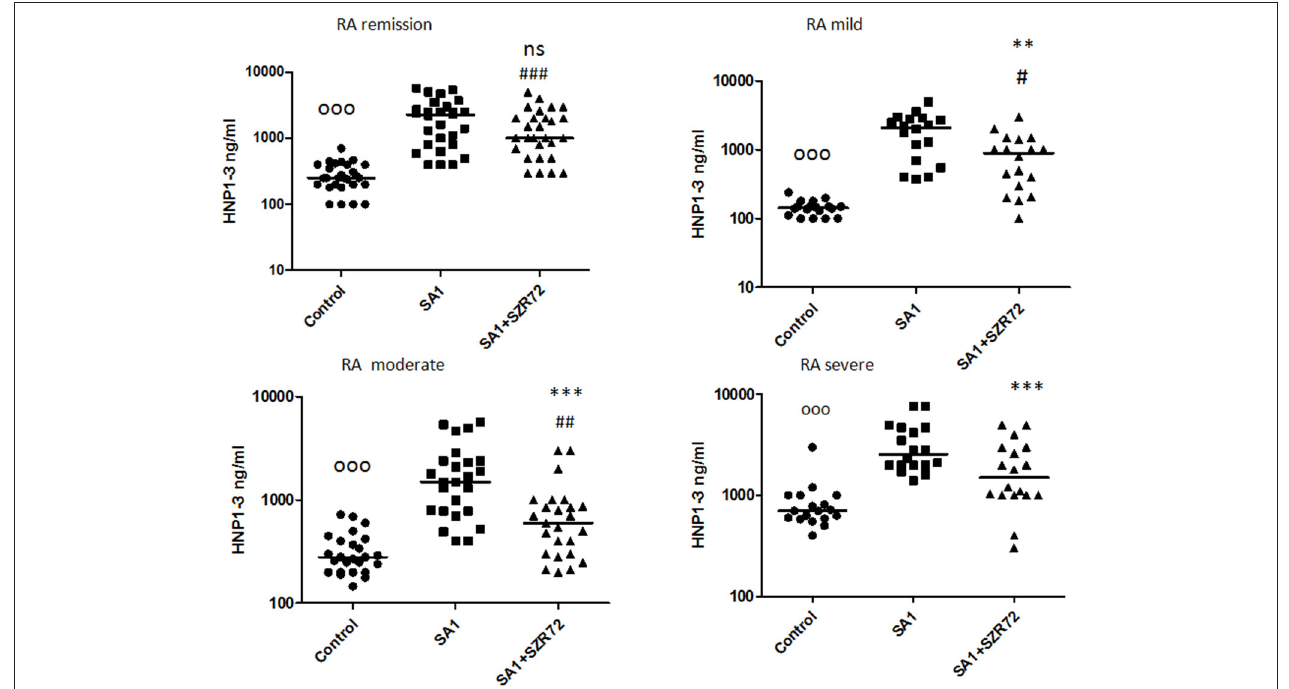
FIGURE 11 | The effect of SZR72 on HNP1–3 production in human whole blood cells of various groups of patients with RA stimulated by heat-inactivated Staphylococcus aureus. Each dot represents the individual value for one subject, and the horizontal lines denote the medians. Significance was determined by the Friedman’s test. Remission group: n = 28, p < 0.0001; control vs. SA1, ooo p < 0.001; control vs. SA1 + SZR72, ### p < 0.001; SA1 vs. SA1 + SZR72, non-significant, according to the Dunn’s post-test. Mild group: n = 18, p < 0.0001, control vs. SA1, ooo p < 0.001; control vs. SA1 + SZR72, # p < 0.05, SA1 vs. SA1 + SZR72, ** p < 0.01 is significant with Dunn’s post-test; moderate group: n = 25, p < 0.0001; control vs. SA1, ooo p < 0.001; control vs. SA1 + SZR72, ## p < 0.01; SA1 vs. SA1 + SZR72, *** p < 0.001 significant according to the Dunn’s post-test. Severe group: n = 18, p < 0.0001; ooo p < 0.001; control vs. SA1,